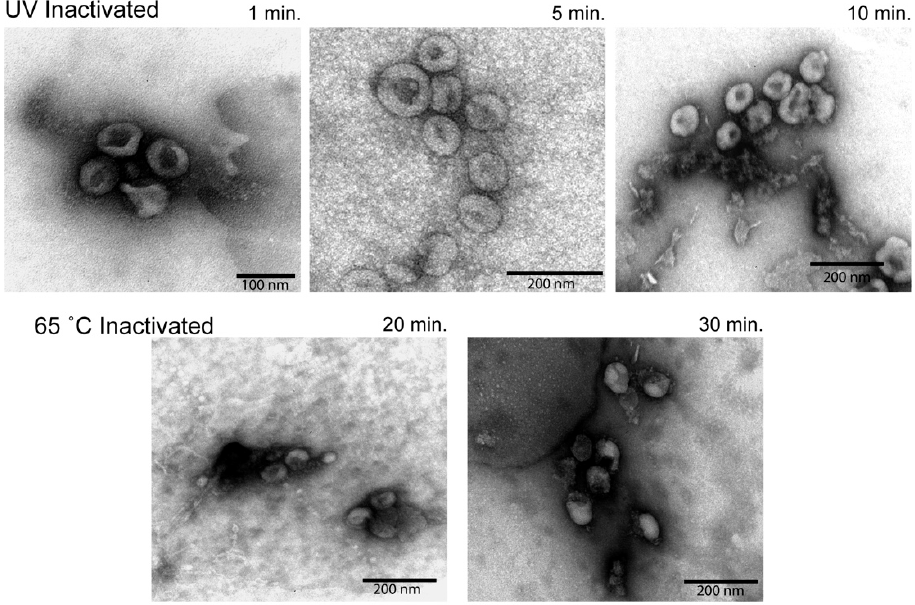
Figure 4. Electron microscopy analysis of virion morphology. Semi-purified virion preparations were spotted onto a grid and imaged to assess virion morphology. The top row of images was taken from UV inactivated samples. The bottom row of images was taken from heat inactivated samples. Relative size is indicated by the scale bar in the lower corner of each image.